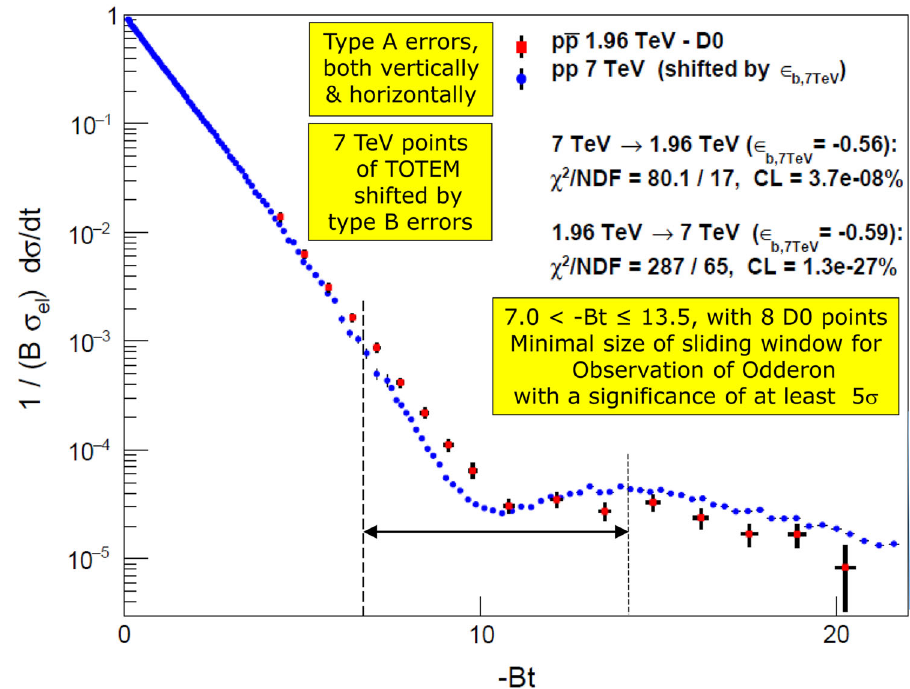
Fig. 29 Model independent determination of the dominant source of the Odderon signal,